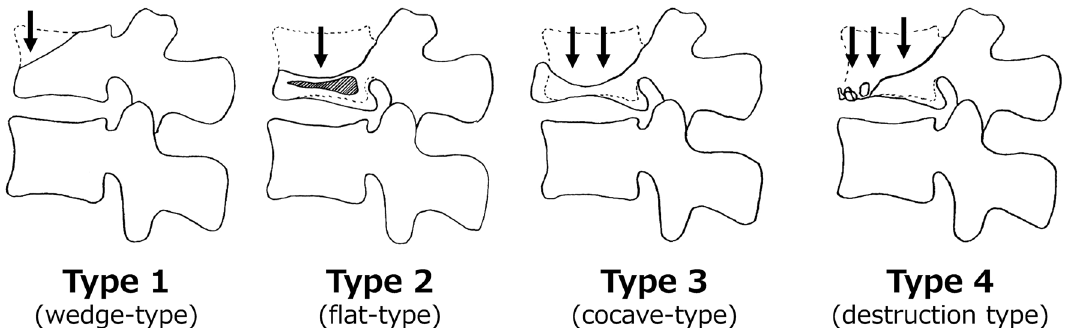
Figure 3. Osteoporotic vertebral collapse (OVC) is classified into four types based on findings on lateral radiographs and MRI: type 1 (wedge collapse), in which the ratio of anterior to posterior height of the vertebral body is < 60%; type 2 (flat or vertebra plana), with uniform compression and often intervertebral cleft formation; type 3 (concave), with an anterior spur or sclerotic changes, or an H shape; and type 4 (burst fracture), with severe destruction of the anterior vertebral